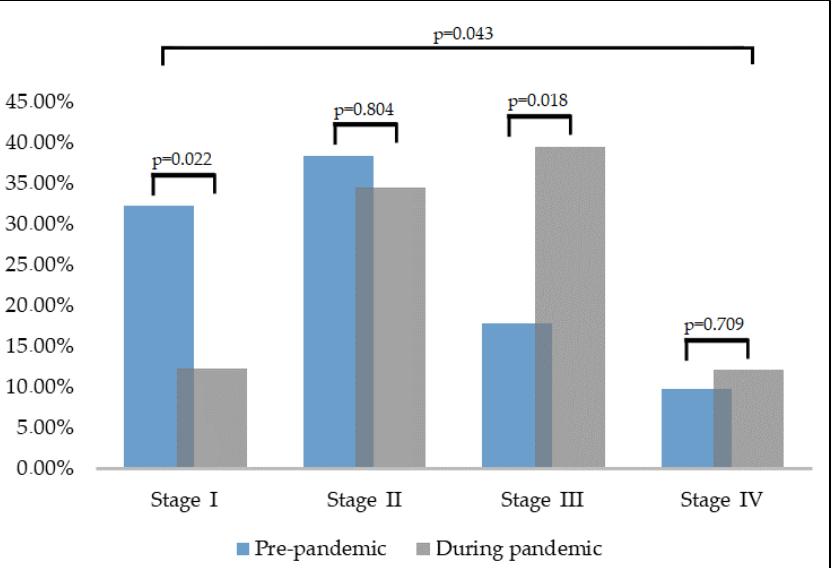
Figure 3. Screening outcomes for cervical cancer stages before and during the COVID-19 pandemic. The period reported as before the pandemic ranges between 2018 and 2019, while the period during the pandemic ranges between 2020 and 2021.